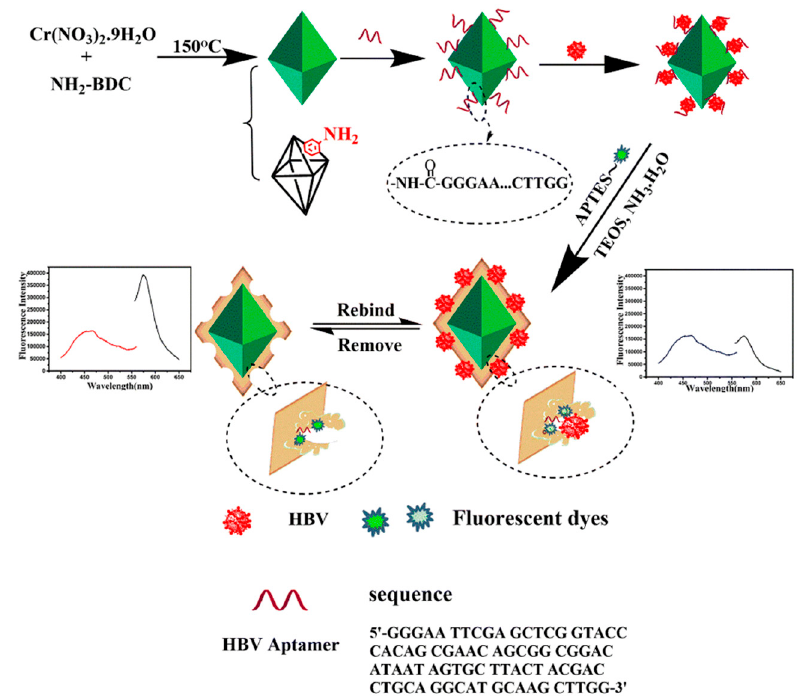
Figure 4. Construction and detection principle of MIP–aptamer. Reproduced with permission from [46]. Copyright Springer, 2021.